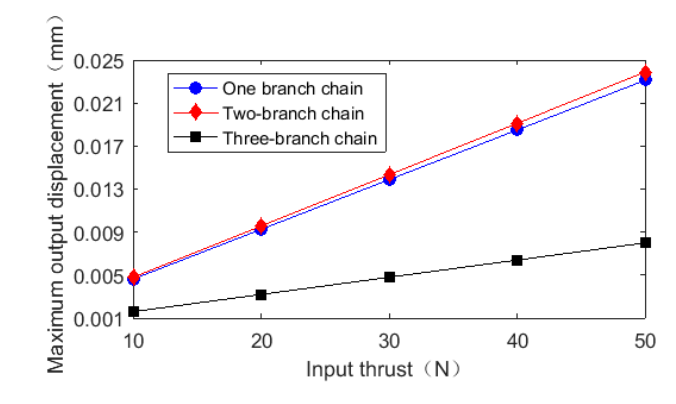
Figure 8. Relationship input thrust and maximum output displacement.